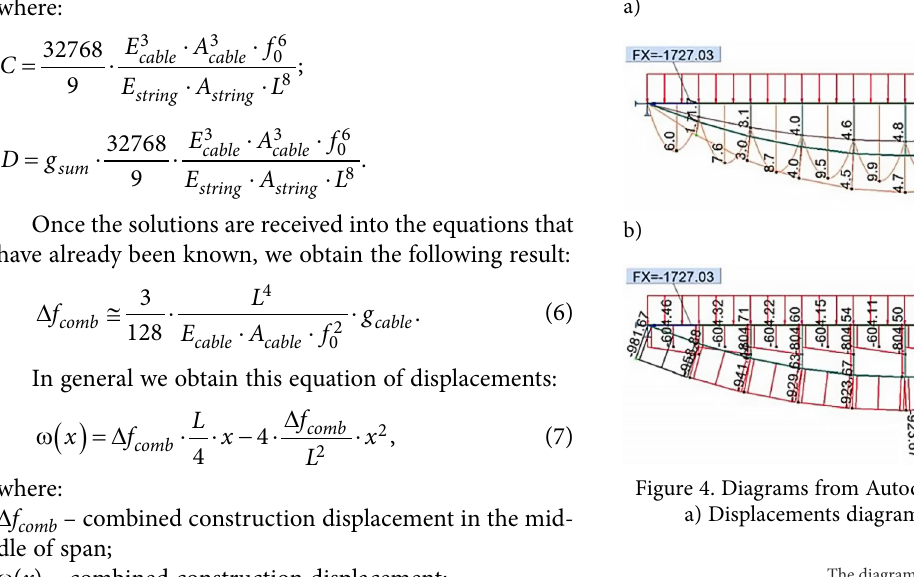
diagram of displacements: sag of cable L/10, external load 10 kN/m